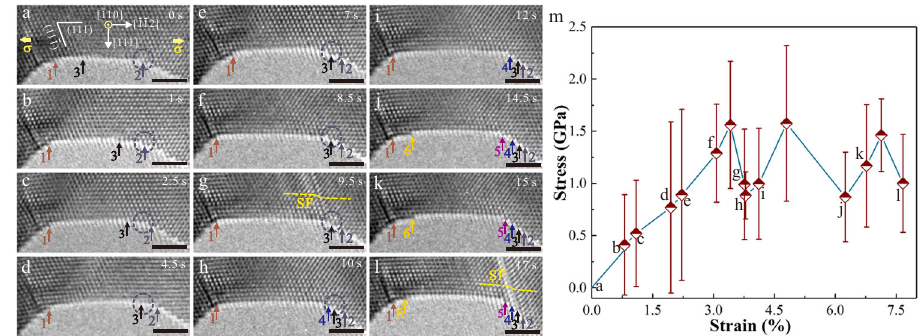
Fig. 2 Dislocation nucleation assisted by surface diffusion in an Ag NW. a , TEM image of a pristine 6.6-nm-diameter Ag NW under < 112 > tensile loading at room temperature and a strain rate of ~ 10 − 3 s − 1 . b – f , Sequential TEM images showing the lateral migration of three atomic steps (surface atom diffusion) on the {111} surface of the Ag NW. The initial position of step 2 was marked by a navy blue circle. g , A partial dislocation activity observed at the overlapping position of steps 2 and 3. h , A one-layer surface step (step 4) formed by the elimination of a stacking fault. i-l , Sequential TEM images showing the plastic fl ow of the Ag NW with a small number of surface diffusion. All scale bars are 2 nm. Each surface step is tracked by an arrow of speci fi c color. m , Lattice stress versus applied strain curve during tensile loading; points ( a – l ) indicate the states of deformation shown in the TEM images of a – l . The error bars represent the variations of the measured lattice stresses at different locations of the nanowire.